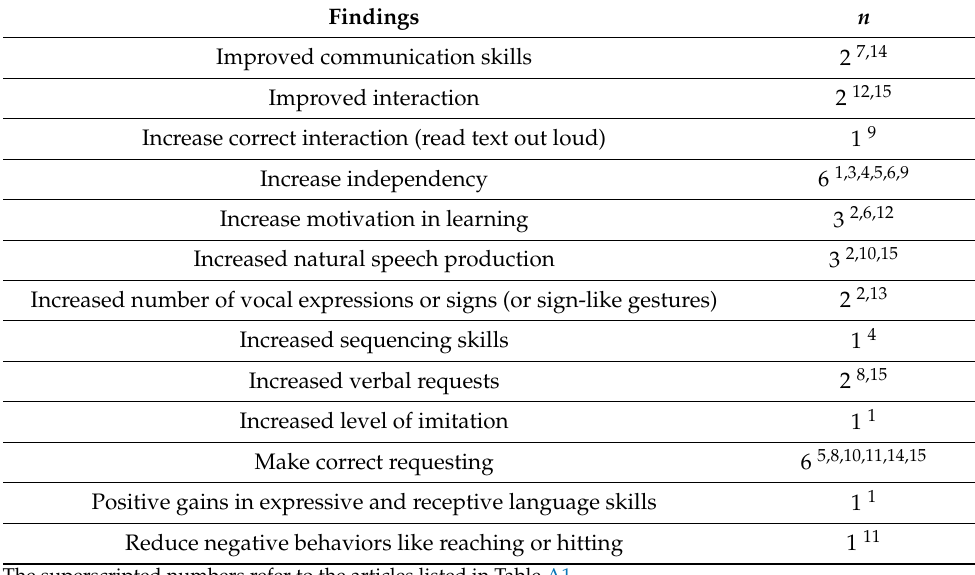
Table 8. Intervention